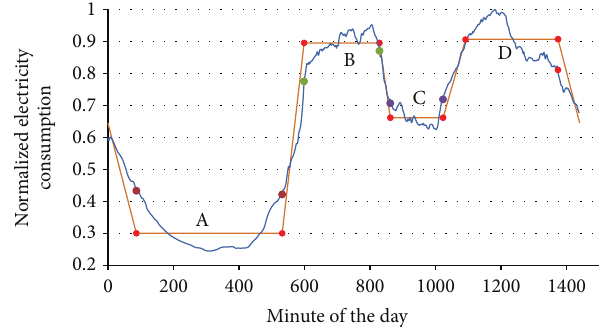
Figure 5: Original and linearized load